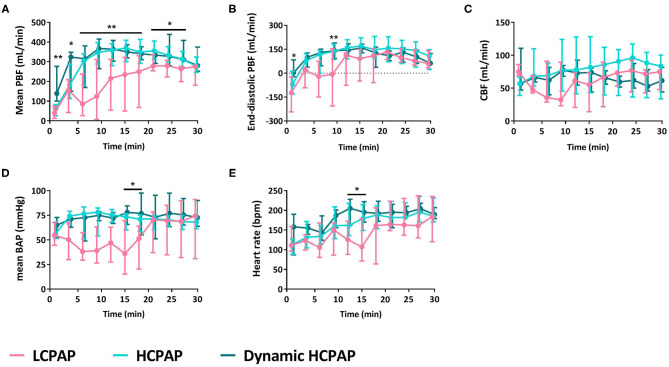
Cardiovascular outcomes. Median (Q1–Q3) of mean (A) and end-diastolic (B) pulmonary blood flow (PBF), cerebral blood flow (CBF, C), mean brachial artery pressure (BAP, D), and heart rate (E) in lambs receiving LCPAP vs. HCPAP vs. dynamic HCPAP in the first 30 min after birth (t0 = cord clamping). All parameters were compared over time using linear mixed-effect regression models. One (*) or two asterisks (**) indicate significant difference between the LCPAP vs. (dynamic) HCPAP or LCPAP vs. both HCPAP groups, respectively.